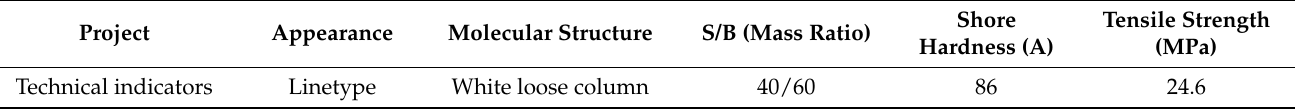
Table 1. Basic Performance Parameters of SBS.